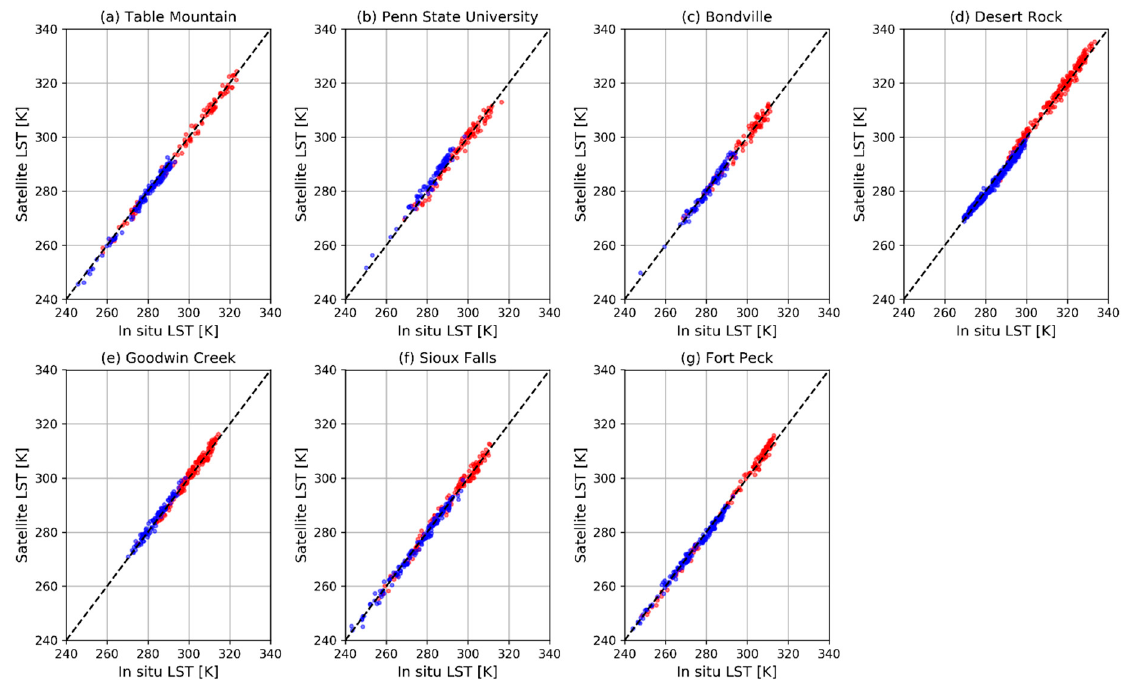
Figure 3. LST validation for the GlobTemperature Aqua-MODIS LST product (GT_MYD_2P) over seven SURFRAD validation sites: ( a ) Table Mountain, ( b ) Penn State University, ( c ) Bondville, ( d ) Desert Rock, ( e ) Goodwin Creek, ( f ) Sioux Falls, ( g ) Fort Peck; covering the year of 2011. Daytime matchups are in red, and nighttime matchups are in blue.